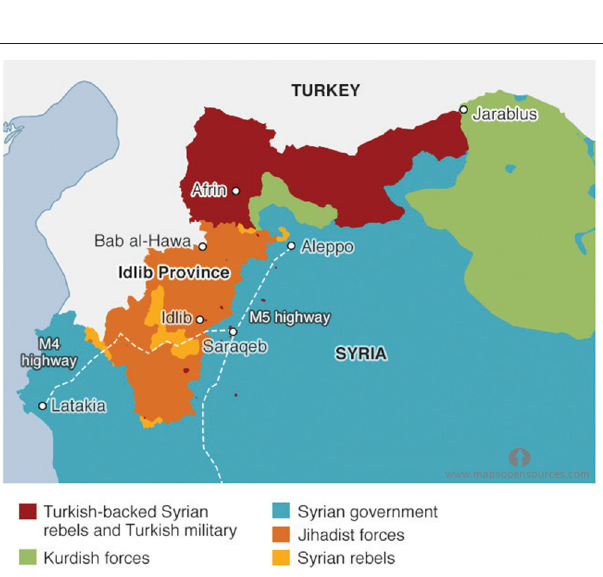
FIGURE 4 | Map of Syria showing geographic areas controlled by each armed group during